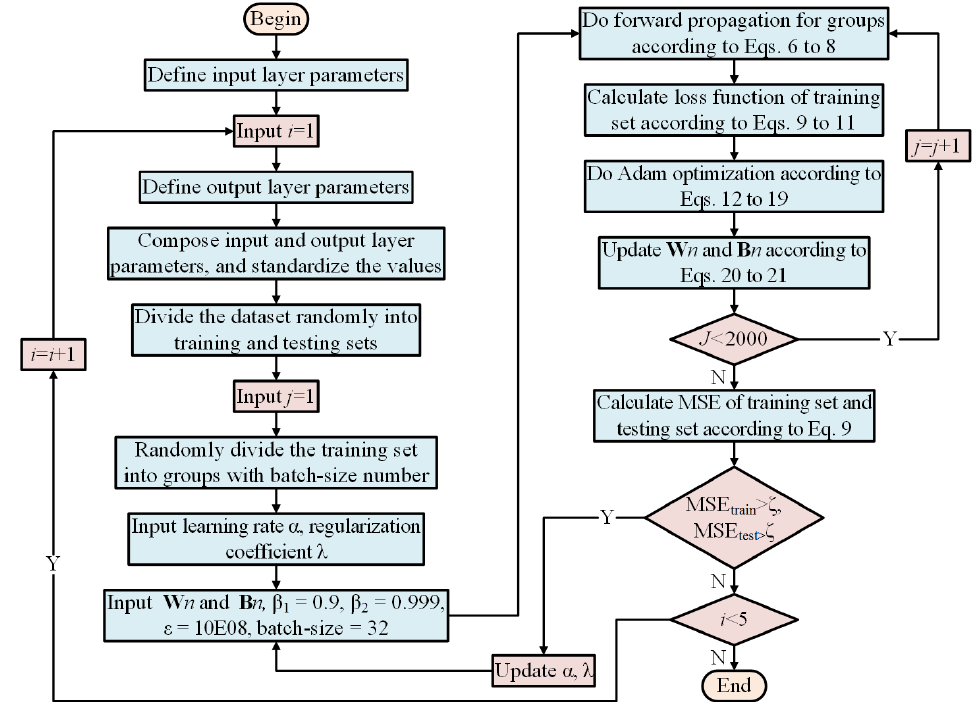
Figure 4. The procedure of DNN